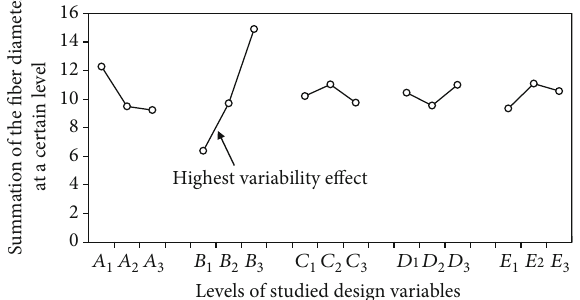
Figure 3: Graphical representation of the main e ff ects of electrospinning control